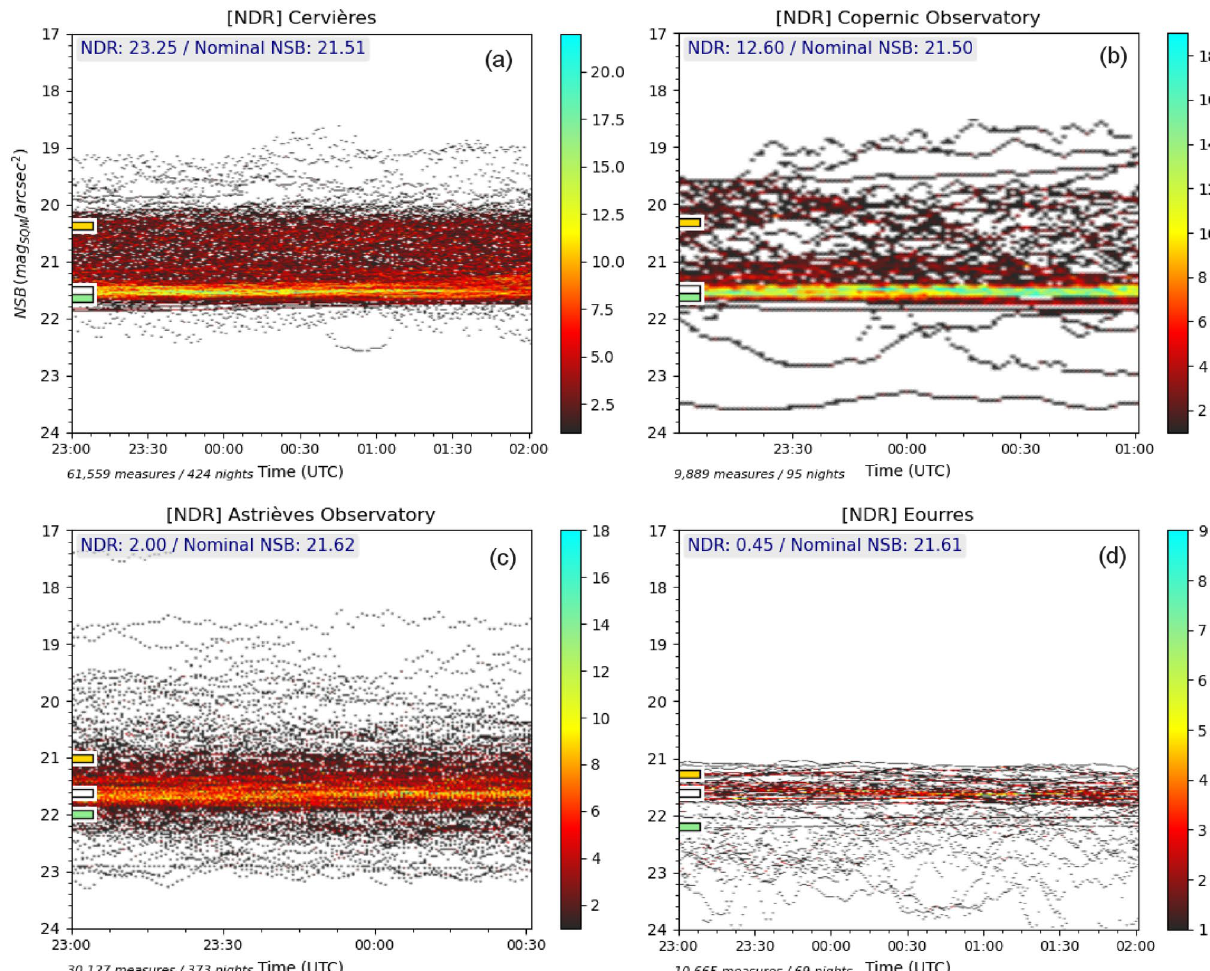
Figure 10. NSB density histograms of 4 different sites used to compute the NDR indicator. The nominal NSB (which corresponds to the most common clear sky conditions) is noted with a white tick mark next to the vertical axis. Relative levels of the bright and dark dispersion terms ( ( N b · MAD b ) and ( N d · MAD d ) ) are noted respectively with an orange tick mark and a green tick mark. The computed values of the NDR indicator and nominal NSB are provided in the top-left corner of each